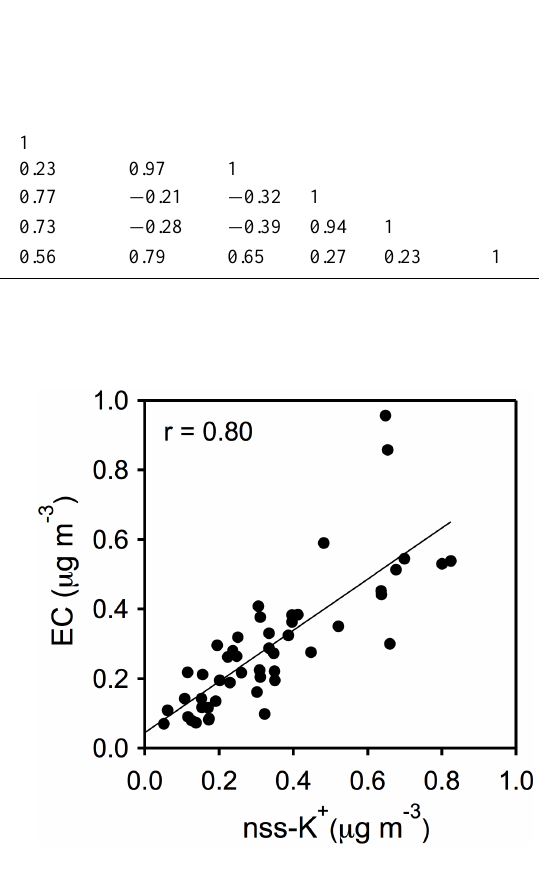
Fig. 12. Correlation analysis between nss-K and EC in ambient aerosols collected from Cape Hedo, Okinawa.